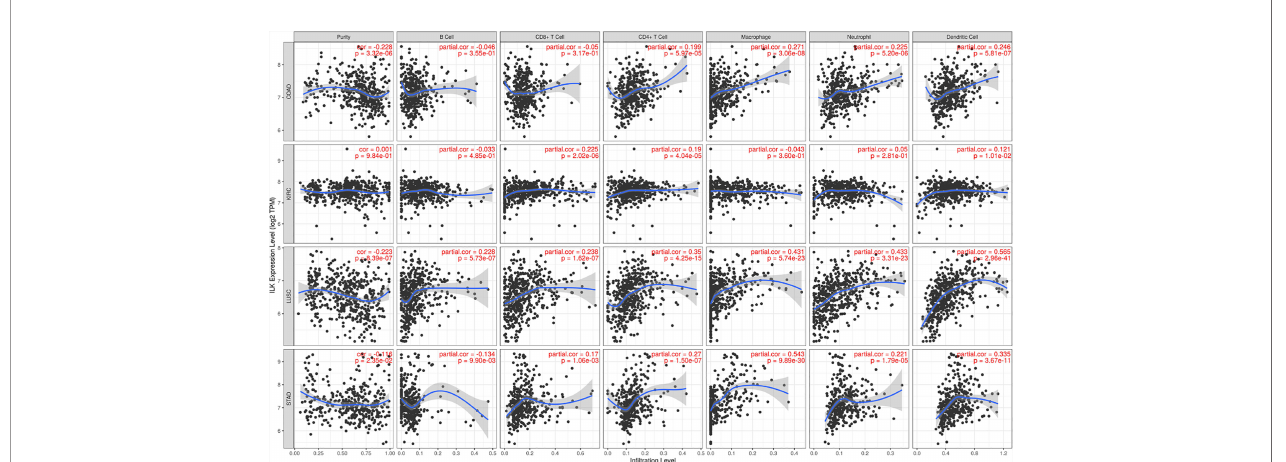
FIGURE 4 | ILK expression is negatively correlated with tumor purity and positively correlated with immune cell in fi ltration in COAD, STAD and LUSC. The correlations between ILK gene expression and tumor purity are on the left panel. The correlation between ILK and immune cells including B cells, CD8 + T cells, CD4 + T cells, macrophages, neutrophils and DCs are corrected by tumor purity (partial.cor, partial Spearman ’ s correlation rho). (upper row) COAD; (second row) KIRC; (third row) LUSC; (lower row) STAD. Signi fi cant P -value is < 0.05.